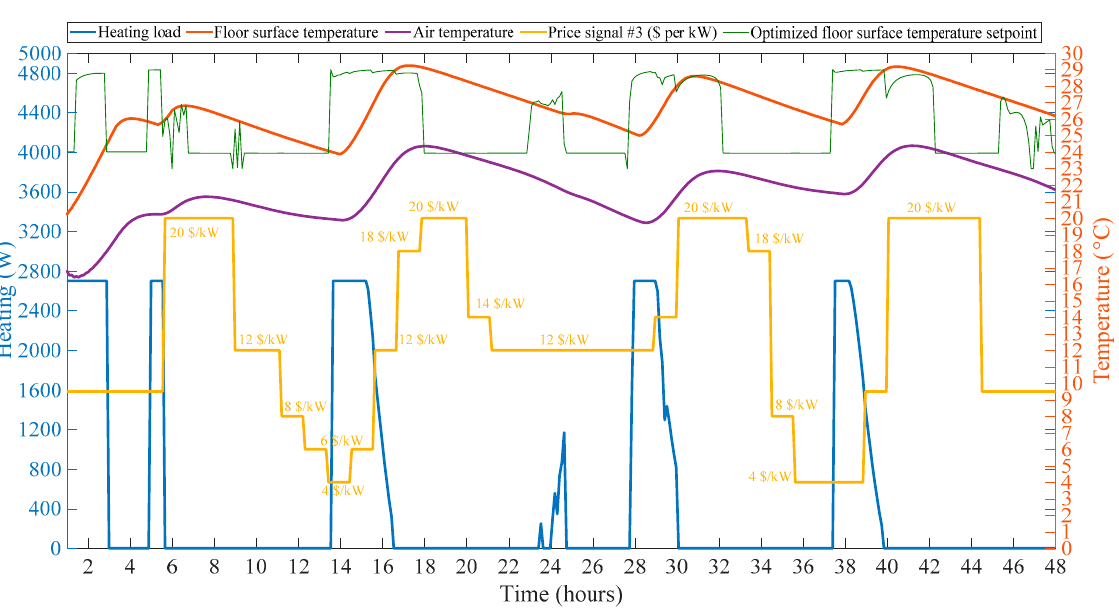
Figure 15. Predictive strategy for price signal #3.